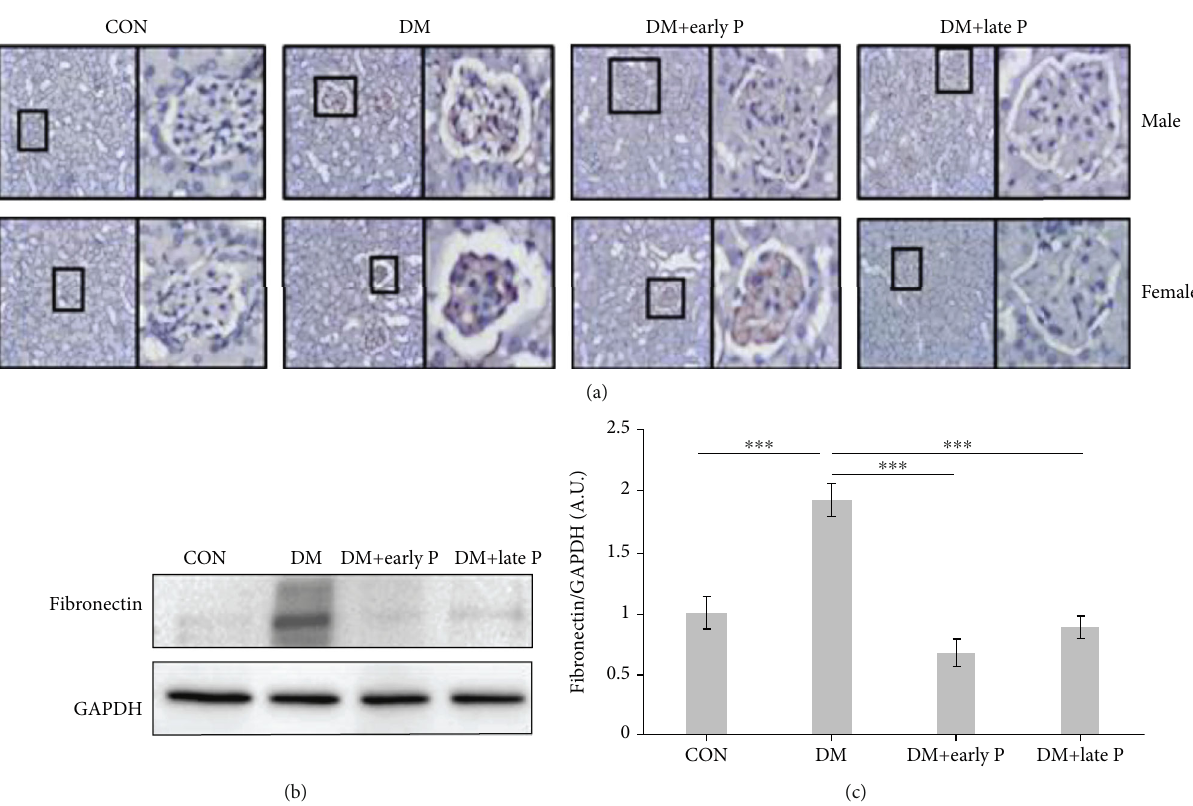
Figure 5: Villin expression in mouse renal tissues. (a) Immunohistochemistry analysis of villin expression in mouse renal sections. Staining intensity of villin was lower in DM as compared to control (CON) mice. Paricalcitol treatment (DM+early P, DM+late P treatments) restored villin levels. Magni fi cation, × 20. (b) Representative western blots of villin and GAPDH proteins extracted from mouse renal tissues. (c) Quanti fi cation of total western blots. Renal villin levels were signi fi cantly lower in DM mice ( n = 12 ) as compared to control mice ( n = 11 ) ( ∗ p < 0 : 001 ) and were signi fi cantly higher in paricalcitol-treated mice (DM+early P ( n = 10 ), DM+late P ( n = 13 ) treatments) as compared to DM mice ( ∗∗ p < 0 : 01 , ∗∗∗ p < 0 : 01 , respectively). Error bars correspond to